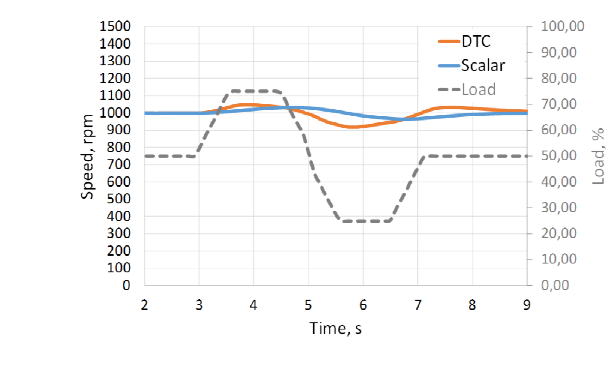
TABLE II. ANALYSIS OF TESTED DRIVE RESPONSE ON VARIABLE LOAD PROFILES.